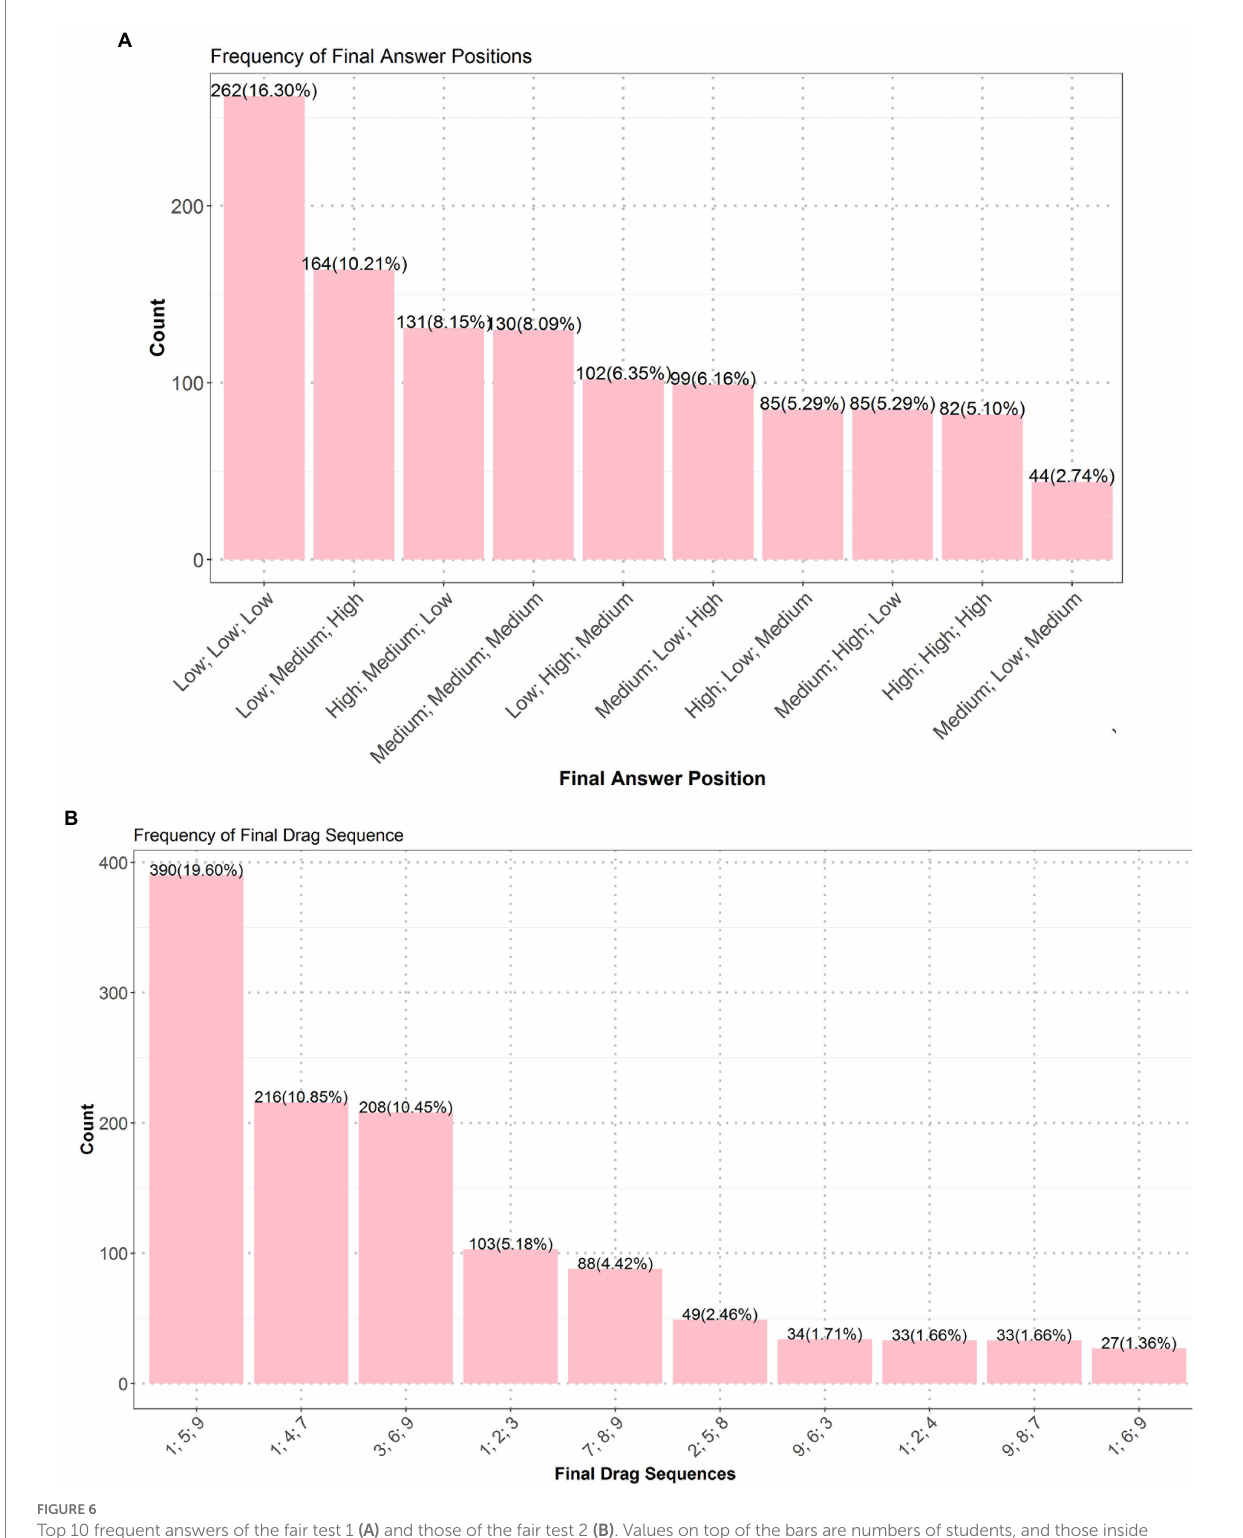
Table 4 shows the means and standard errors of the process features across score groups. As for the fair test 1, the Kruskal– Wallis tests report significant differences of these features across